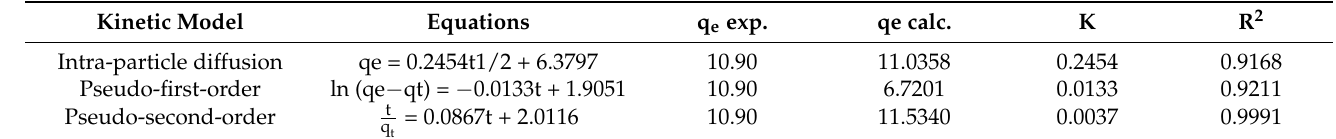
Table 4. Kinetic equations for saponins adsorption by the D101 resin.